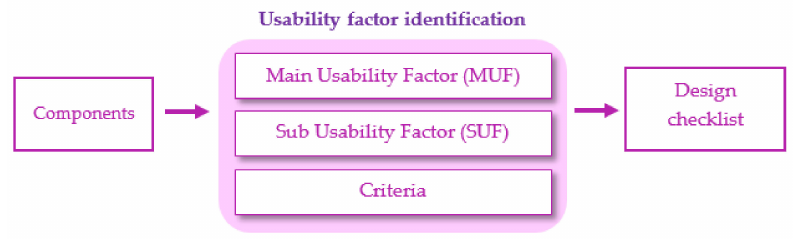
Figure 6. The usability factor identification model.